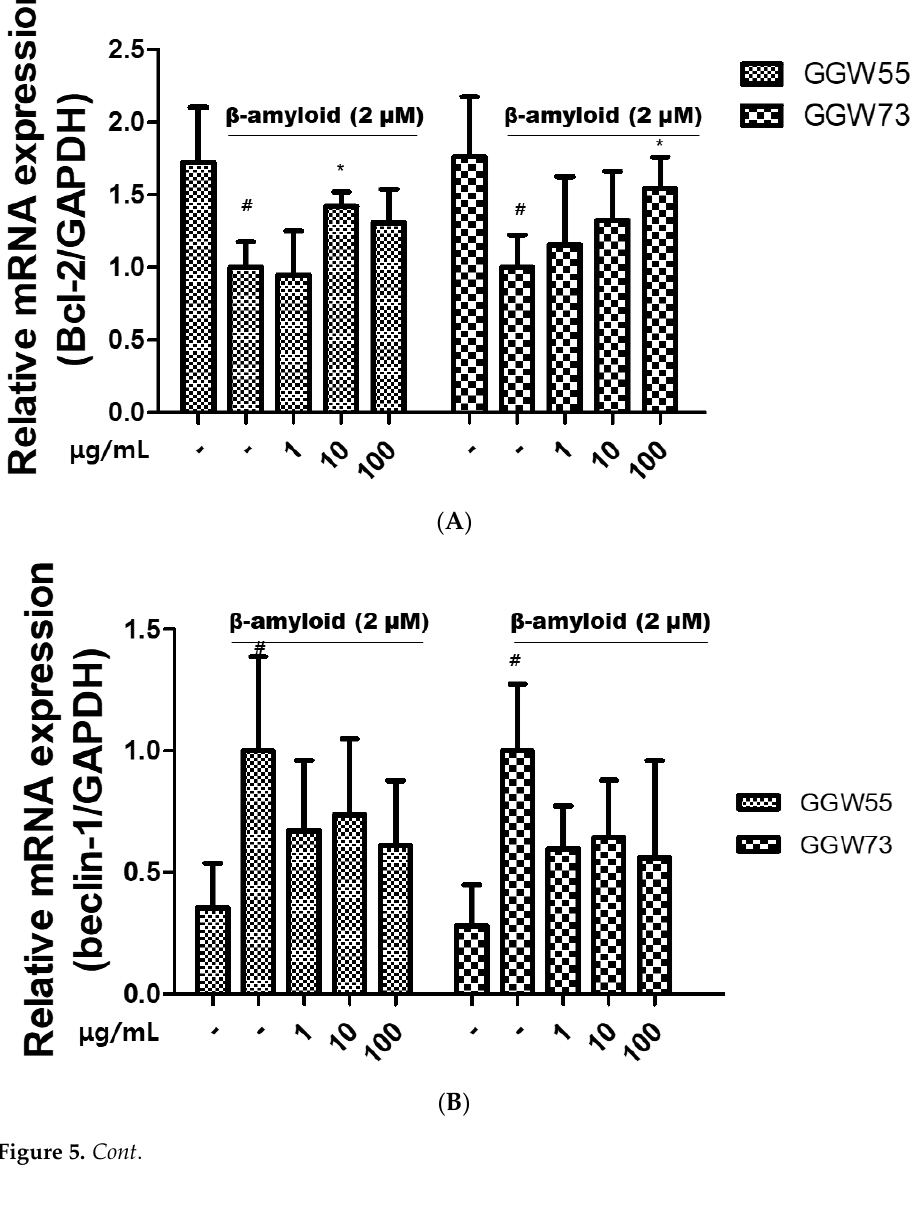
Figure 4. The regulatory effect of GGW on Aβ− stimulated MAPKs expression on neuronal cells.